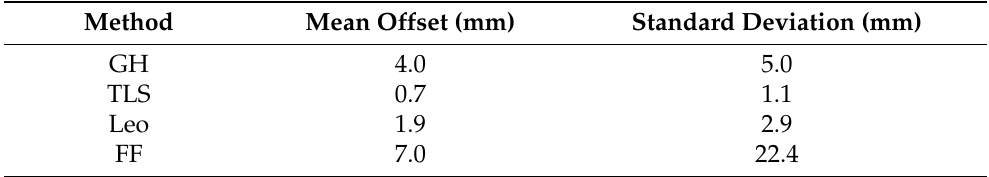
Table 15. Offsets and standard deviations of offsets of defect maximum depth as compared to maximum depth measured from Nikon point clouds. Relative values are excluded due to large variety in defects’ depth but comparatively constant values in offset, which lead to large relative offsets that do not reflect real